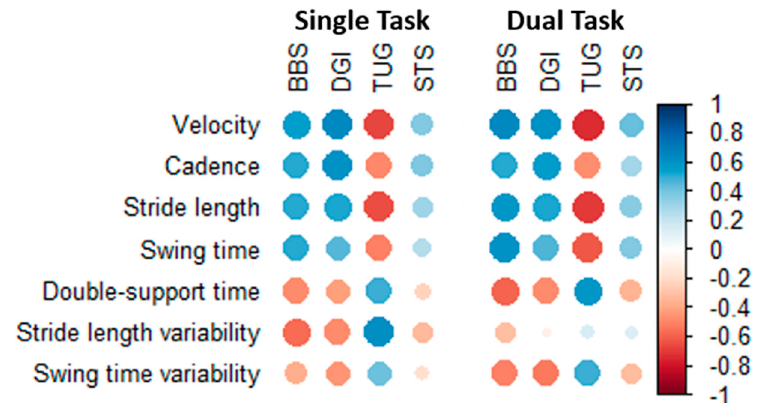
Figure 1. Correlation between GAITRite parameters and functional balance tests in all patients. Blue represents positive correlations, and red represent negative correlations. Color saturation and dot sizes represent correlation strength. Abbreviations: BBS, Bergs Balance Scale; DGI, Dynamic Gait Index; TUG, Timed Up and Go; STS, Sit To Stand test.